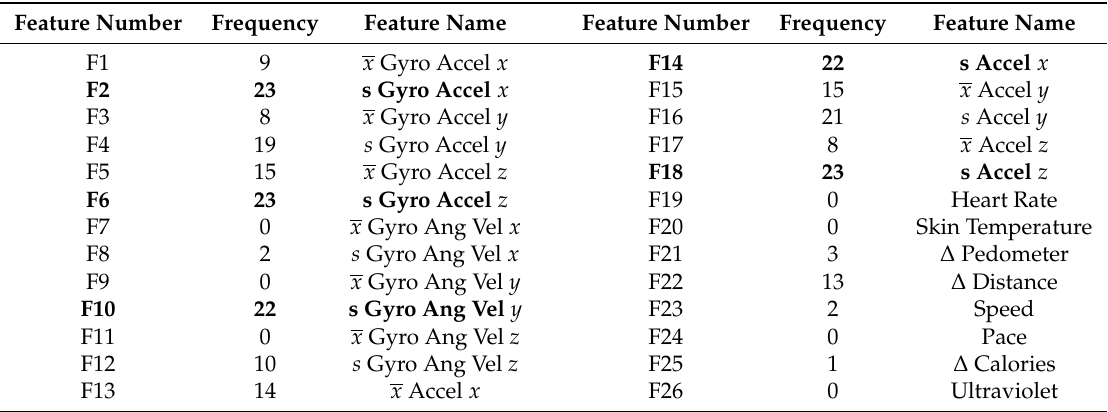
Table 3. Results of the correlation matrix analysis for feature selection in the PRIDE